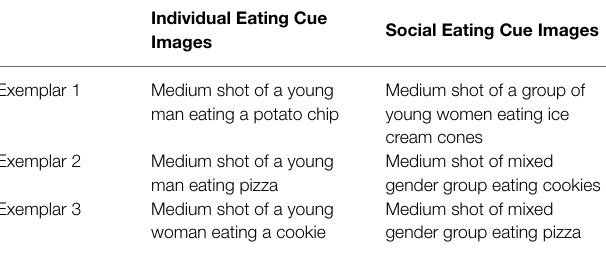
Social Eating Cue